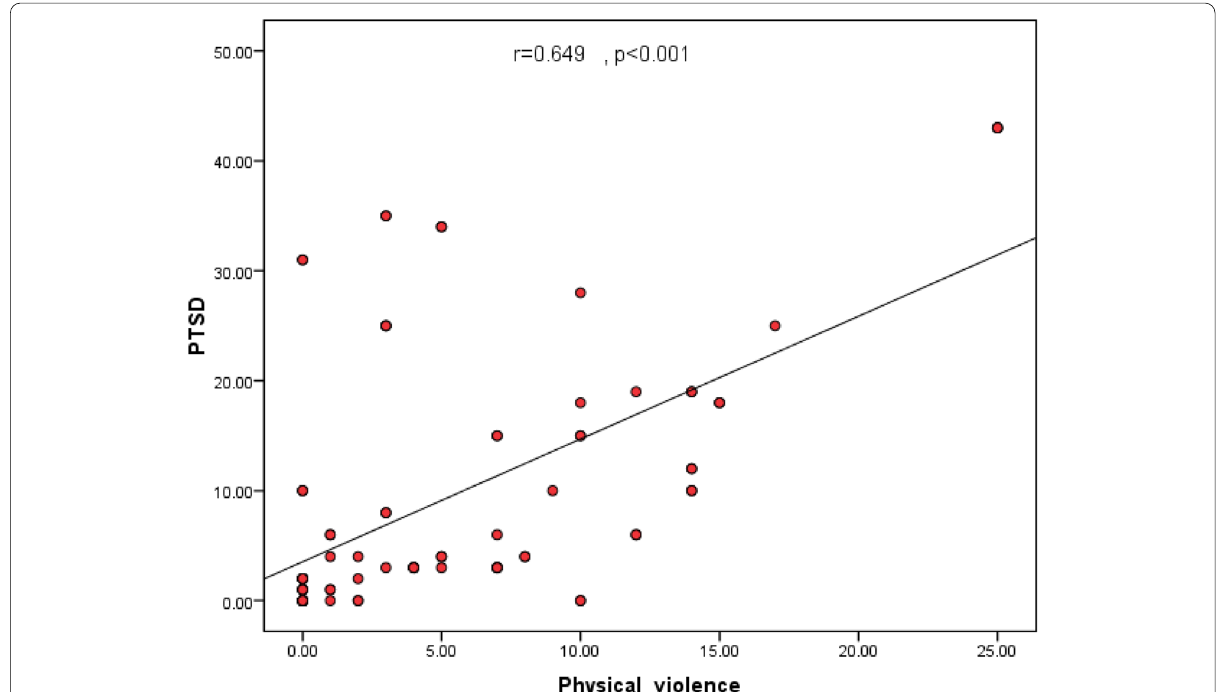
Fig. 3 Scatter diagram showing a correlation between physical violence and post-traumatic stress disorder